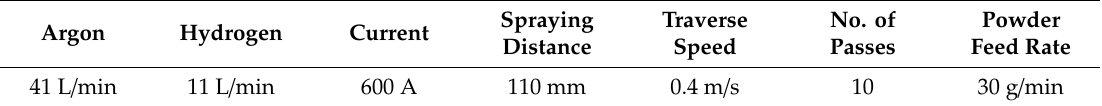
Table 3. The parameters of the APS process with the F6-torch.